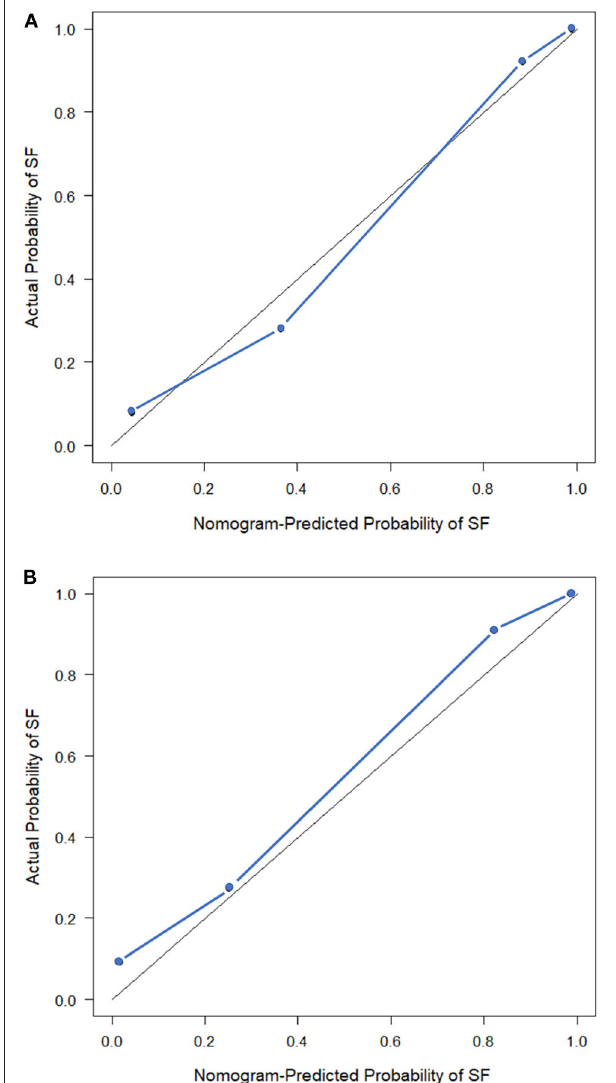
FIGURE 4 | Calibration curves of the clinical–radiomics nomogram. (A) Calibration curve of the clinical–radiomics nomogram in the primary cohort. (B) Calibration curve of the clinical–radiomics nomogram in the validation cohort. Calibration curves describe the calibration of the model with respect to the agreement between nomogram predicted probability of stone free (SF) and actual SF rate. The y-axis depicts actual SF rate. The x-axis depicts the nomogram predicted probability of SF. The diagonal solid line depicts an excellent prediction by a supreme model. The blue dotted line represents the performance of the